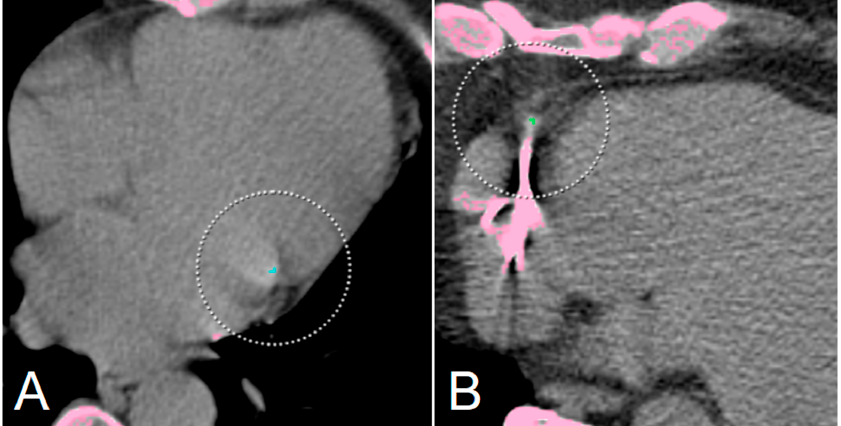
Figure 5. Two representative false-positive ratings from the AI-CACS tool on ungated CT from PET/CT. No coronary calcifications are present in a 66-year-old woman undergoing PET/CT for staging of gastric cancer ( A ), however, small calcifications of mitral valve were falsely marked as ramus circumflexus CAC. In another 66-year-old male patient ( B ), no CAC was found in dedicated gated CAC scan, however, small areas of increased density due to image noise adjacent to a pacemaker electrode were marked as calcification. Note: Pink areas are highlighing dense areas in the CT image (i.e., bone or calcification), with the circles indicating coronary artery